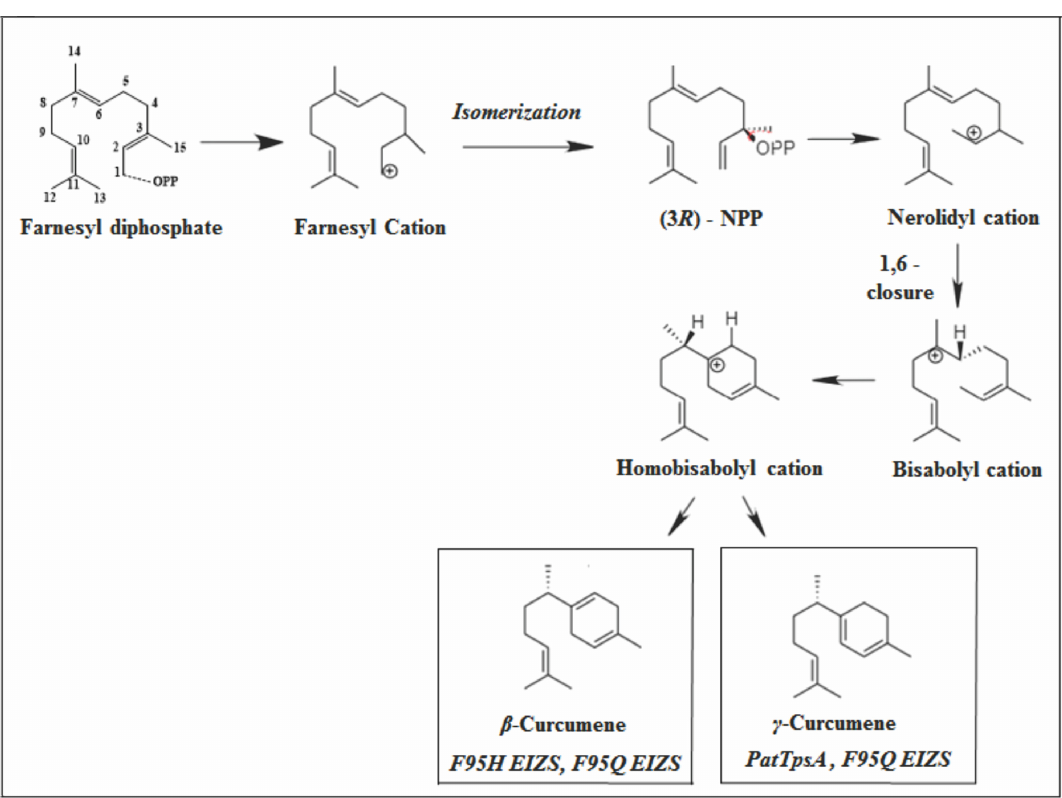
Figure 7. Types of primary cyclization of γ -curcumene and β